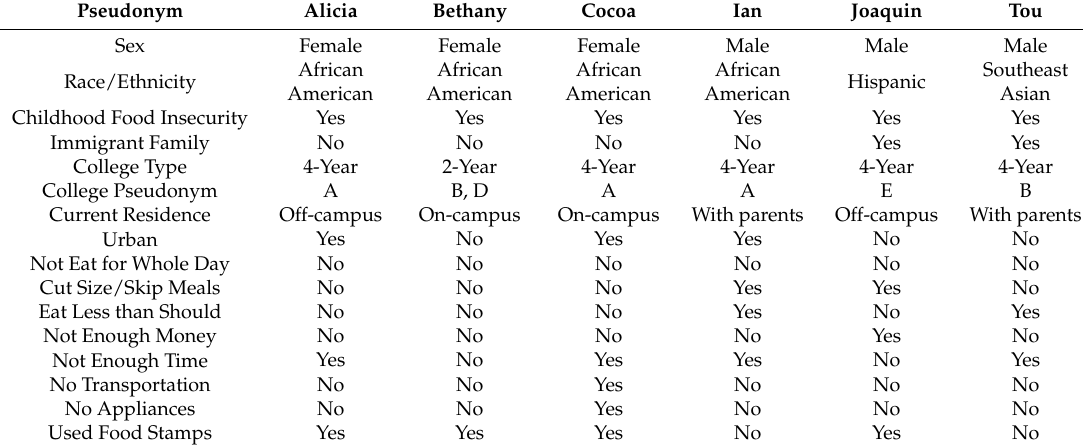
Table A1. Characteristics of interview